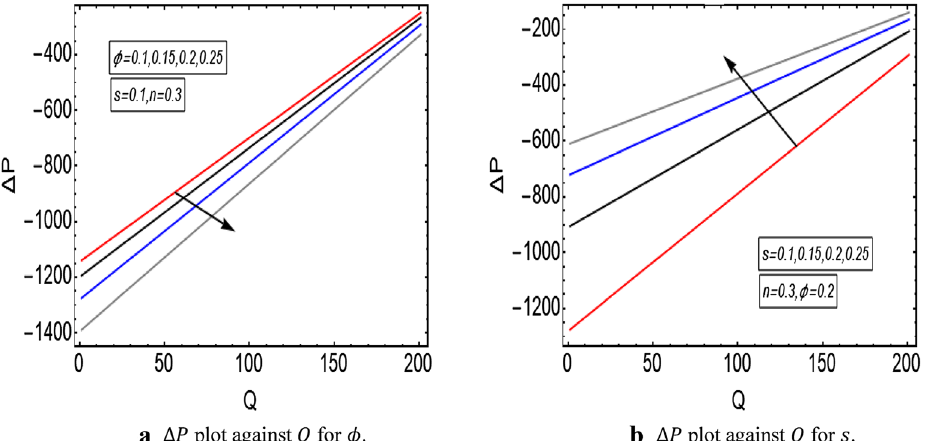
Figure 5. ( a ) (cid:31) P plot against Q for φ . ( b ) (cid:31) P plot against Q for s .